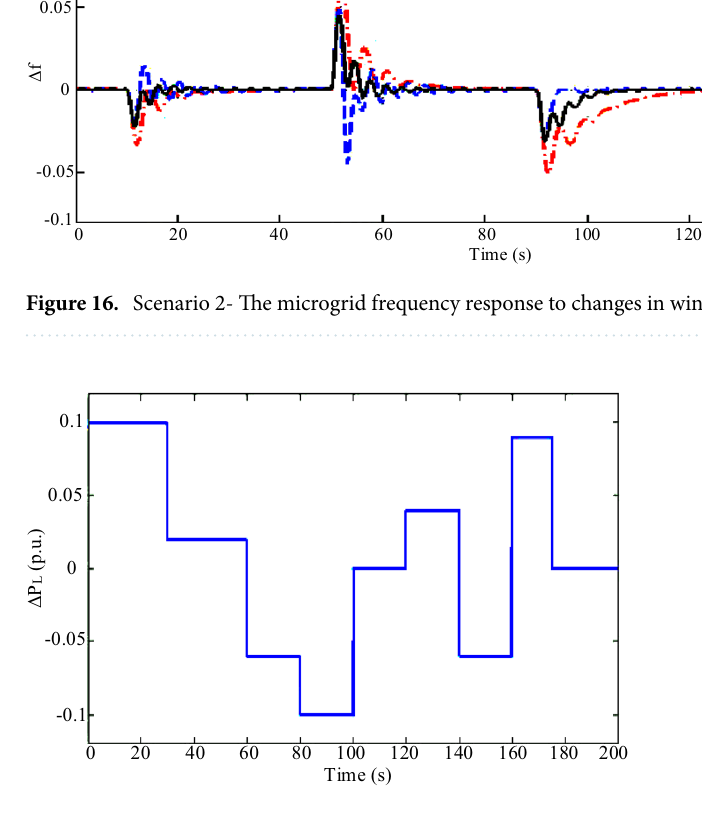
Figure 17. Scenario 3- Load perturbation applied to the microgrid as an irregular pulse train.